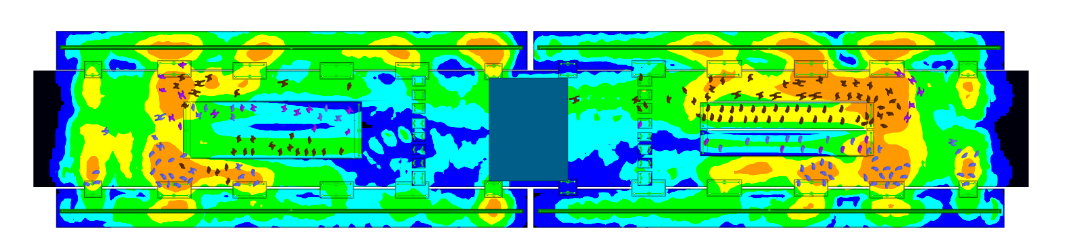
Figure 6 Simulation result of a station design where one can see the experienced density based on Fruin